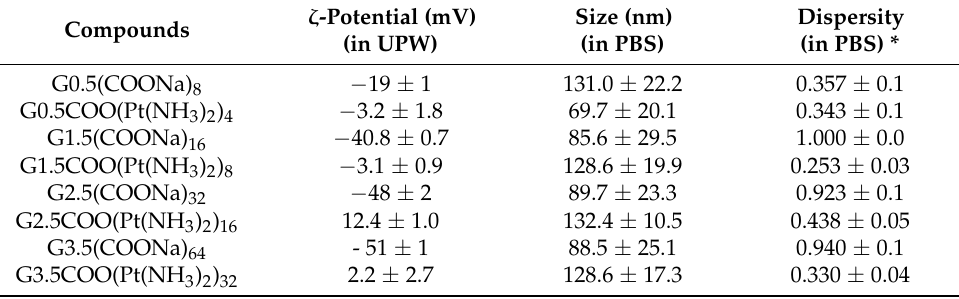
Table 2. ζ -potential, size, and dispersity of anionic PAMAM dendrimers (G0.5-G3.5) and their related metallodendrimers after conjugation with cisplatin in a bidentate form. ζ -Potential (mV) Size (nm) Dispersity Compounds (in UPW) (in PBS) (in PBS) * G0.5(COONa) 8 − 19 ± 1 131.0 ±